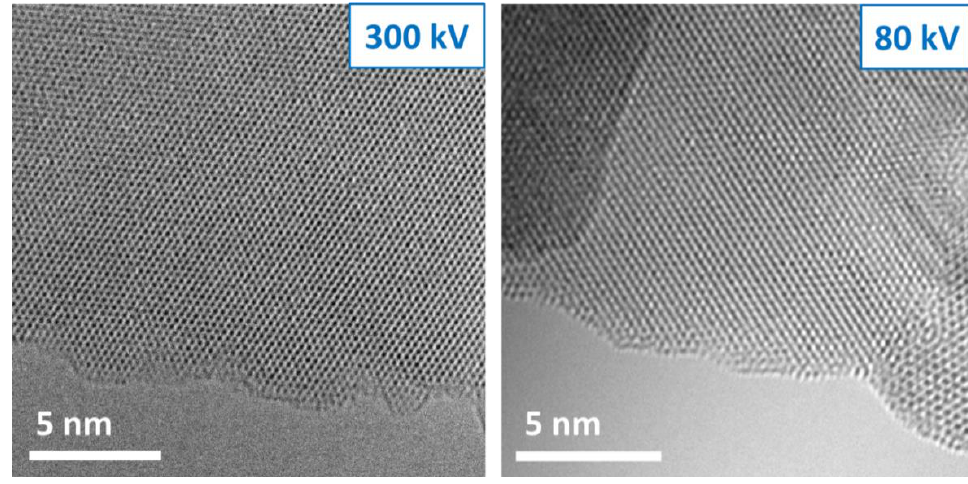
Figure 2. HRTEM micrographs of the Cu 2 O powdered sample analyzed at different electron beam voltages.